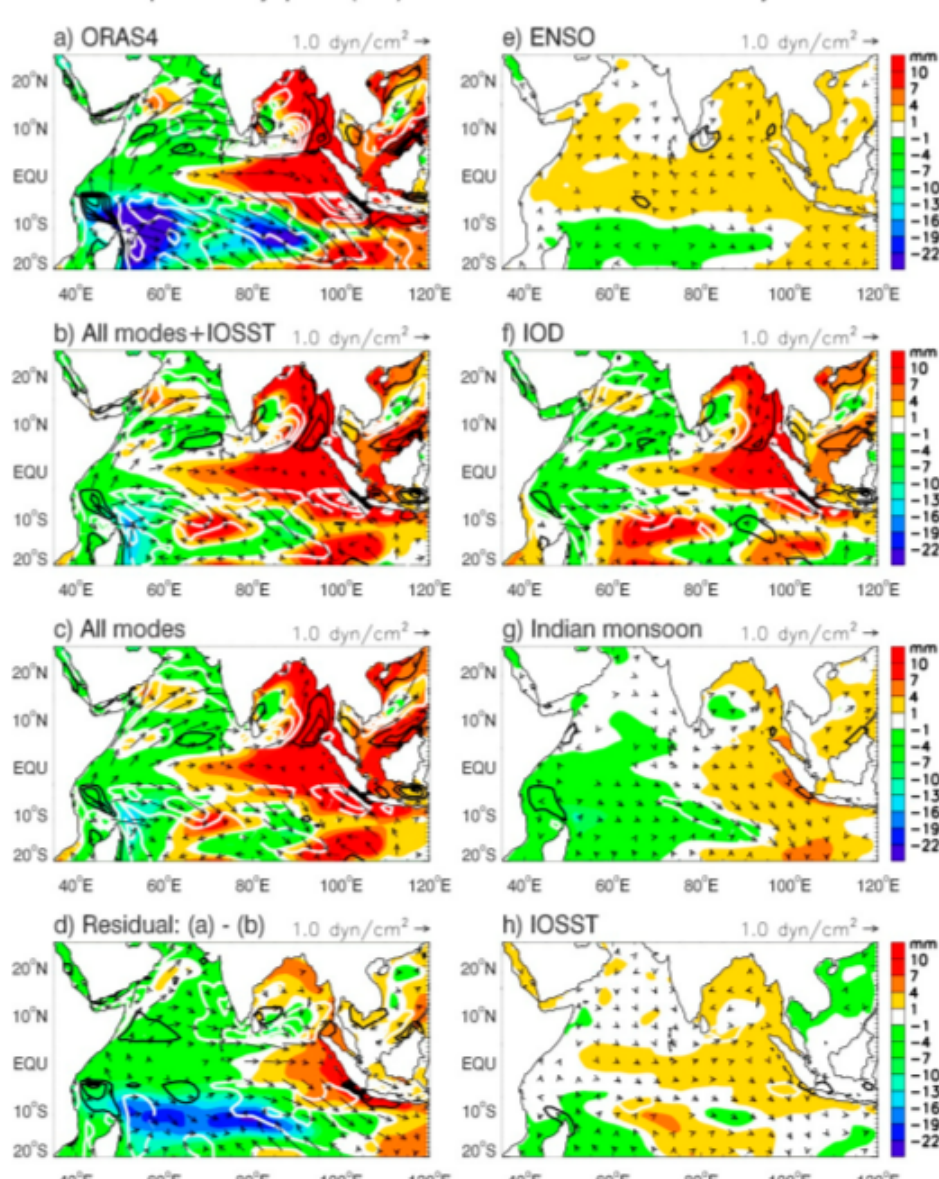
Figure 14. The composite analyses for the May–October mean, 8 year low-passed decadal SLA (color contours), the JRA55 surface wind stress (arrows; units: × 0.2 dyn cm − 2 ), and the Ekman pumping velocity, w e (line contours, positive (negative) values are in white (black), beginning at 1 ( − 1) with an interval of 2; zero contours are omitted; units: × 10 − 7 m s − 1 ), based on the years when the SLA values in the eastern Bay of Bengal (Reg. 4 of Figures 6–10) exceeded the +0.5 STD line shown in Figure